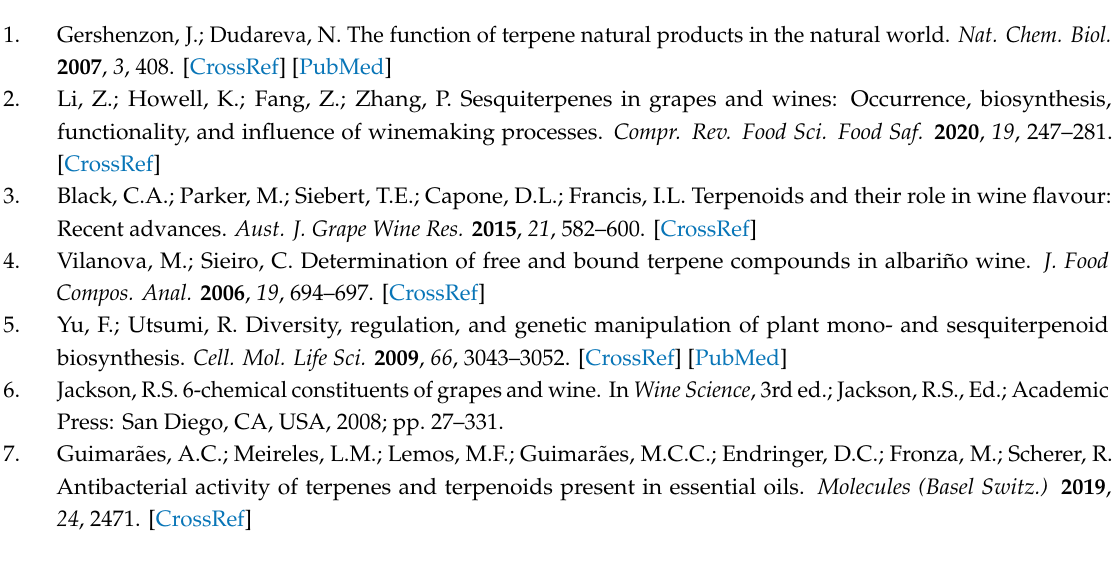
Table S1: Weather conditions during vintages 2016 and 2017 (obtained from the website of the Australian Government Bureau of Meteorology using the Ararat Prison Observation Station data), Table S2: Free terpene concentrations in Shiraz grape at harvest under di ff erent UV attenuation treatments in vintage 2016, Table S3: Free terpene concentrations in Shiraz grape at harvest under di ff erent UV attenuation treatments in vintage 2017. Author Contributions: Conceptualization, K.H. and P.Z.; Data curation, W.M., J.L. (Jiaqiang Luo) and J.L. (Junda Liu); Formal analysis, W.M., J.L. (Jiaqiang Luo), J.L. (Junda Liu) and P.Z.; Investigation, J.L. (Jiaqiang Luo) and P.Z.; Methodology, J.L. (Jiaqiang Luo), J.L. (Junda Liu), K.H. and P.Z.; Project administration, P.Z.; Supervision, K.H. and P.Z.; Writing—original draft, W.M.; Writing—review and editing, W.M., K.H., and P.Z. All authors have read and agreed to the published version of the